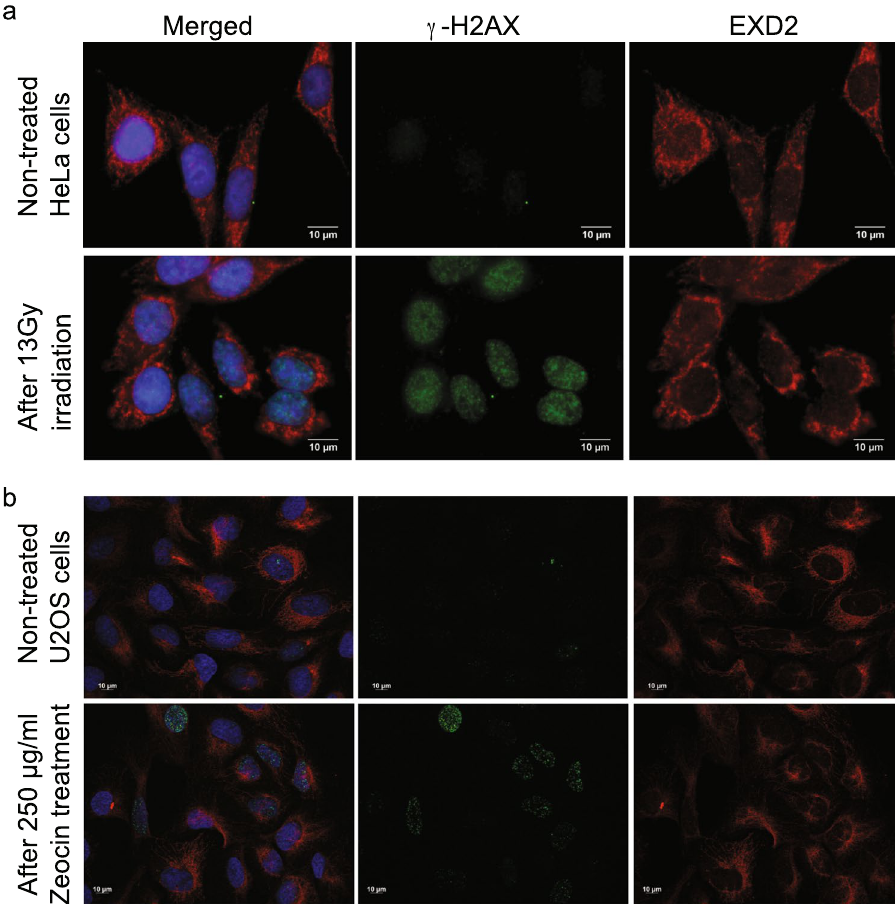
Figure 5. Nuclear DNA-damage does not relocate EXD2 to the nucleus. (panel a) HeLa cells were treated with 13 Gy X-irradiation to induce nuclear DNA damage and allowed to recover for 30 minutes. Results show that H2AX phosphorylation is considerably increased in the nucleus following this damage whereas EXD2 retains its predominant mitochondrial localization similar to its location in control cells. (panel b) U2OS cells were treated with 250 µ g/ml Zeocin for 1 hr and allowed to recover for 1 hr after replacing the Zeocin-containing medium with regular medium. Cells were then processed for IF detection of γ H2AX and EXD2 and show a similar result as the X-irradiation in HeLa